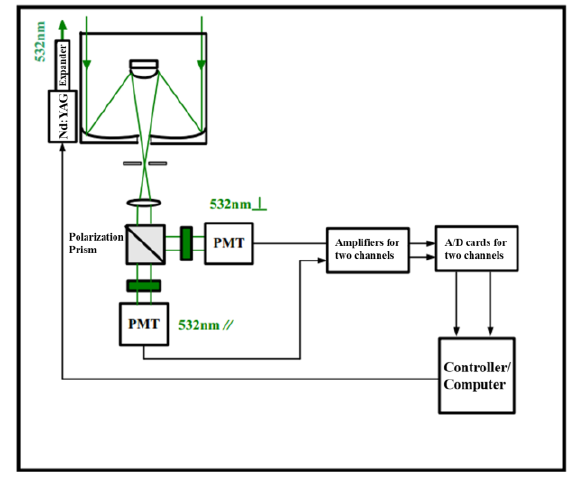
Fig. 2 Schematic diagram of aerosol lidar Table 1 Main parameters of mobile lidar